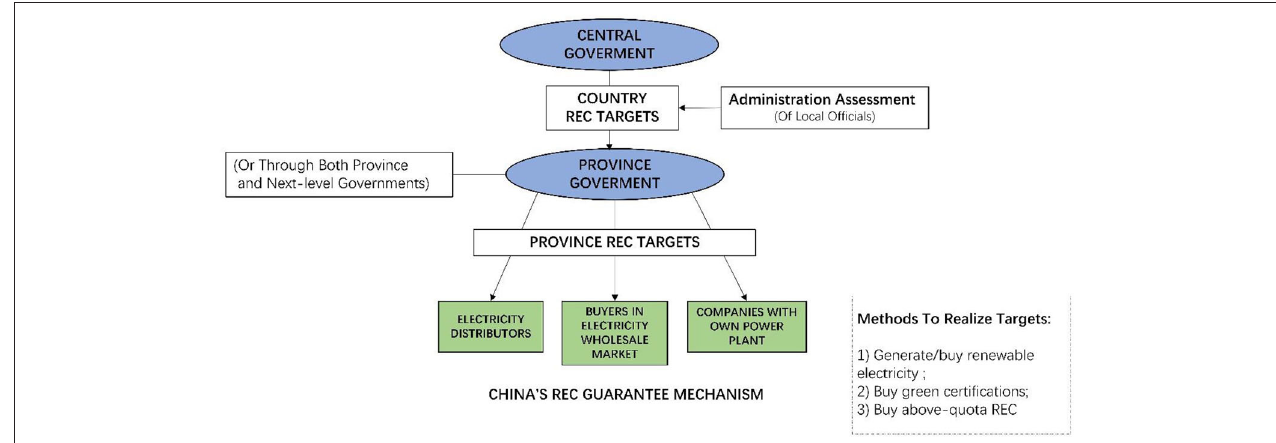
FIGURE 2 | China’s REC guarantee